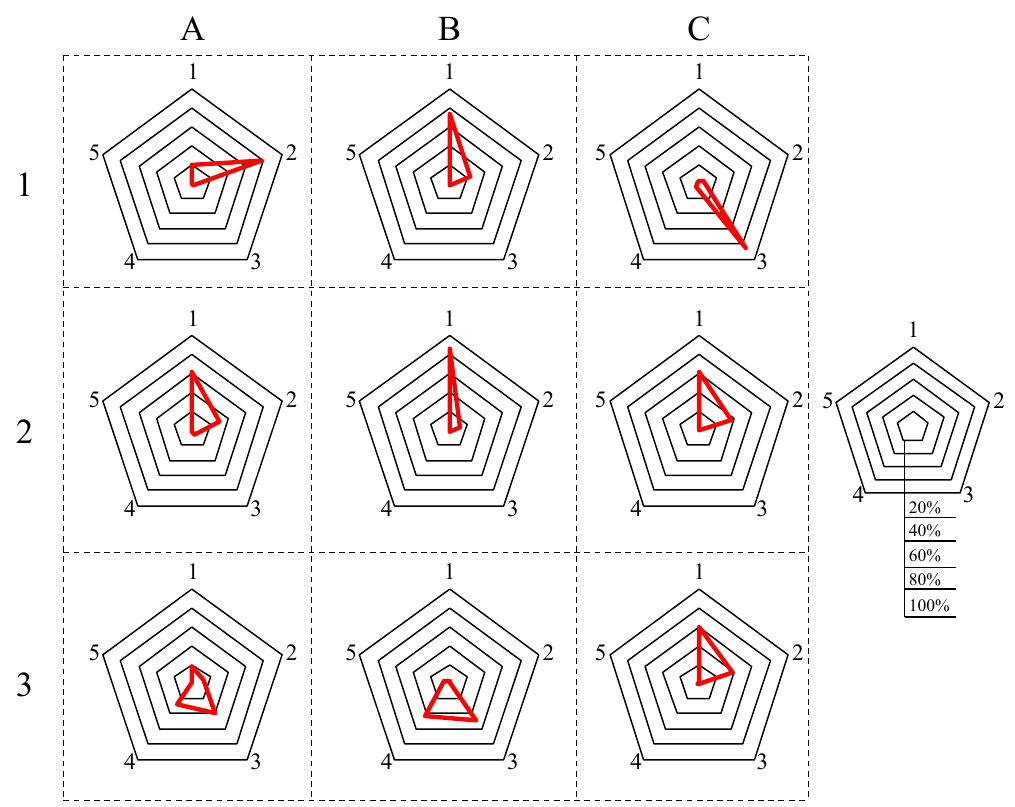
Figure 7. The percentage of building form distribution with optimization of higher than 85% of acceptable UTCI percentage at block level.